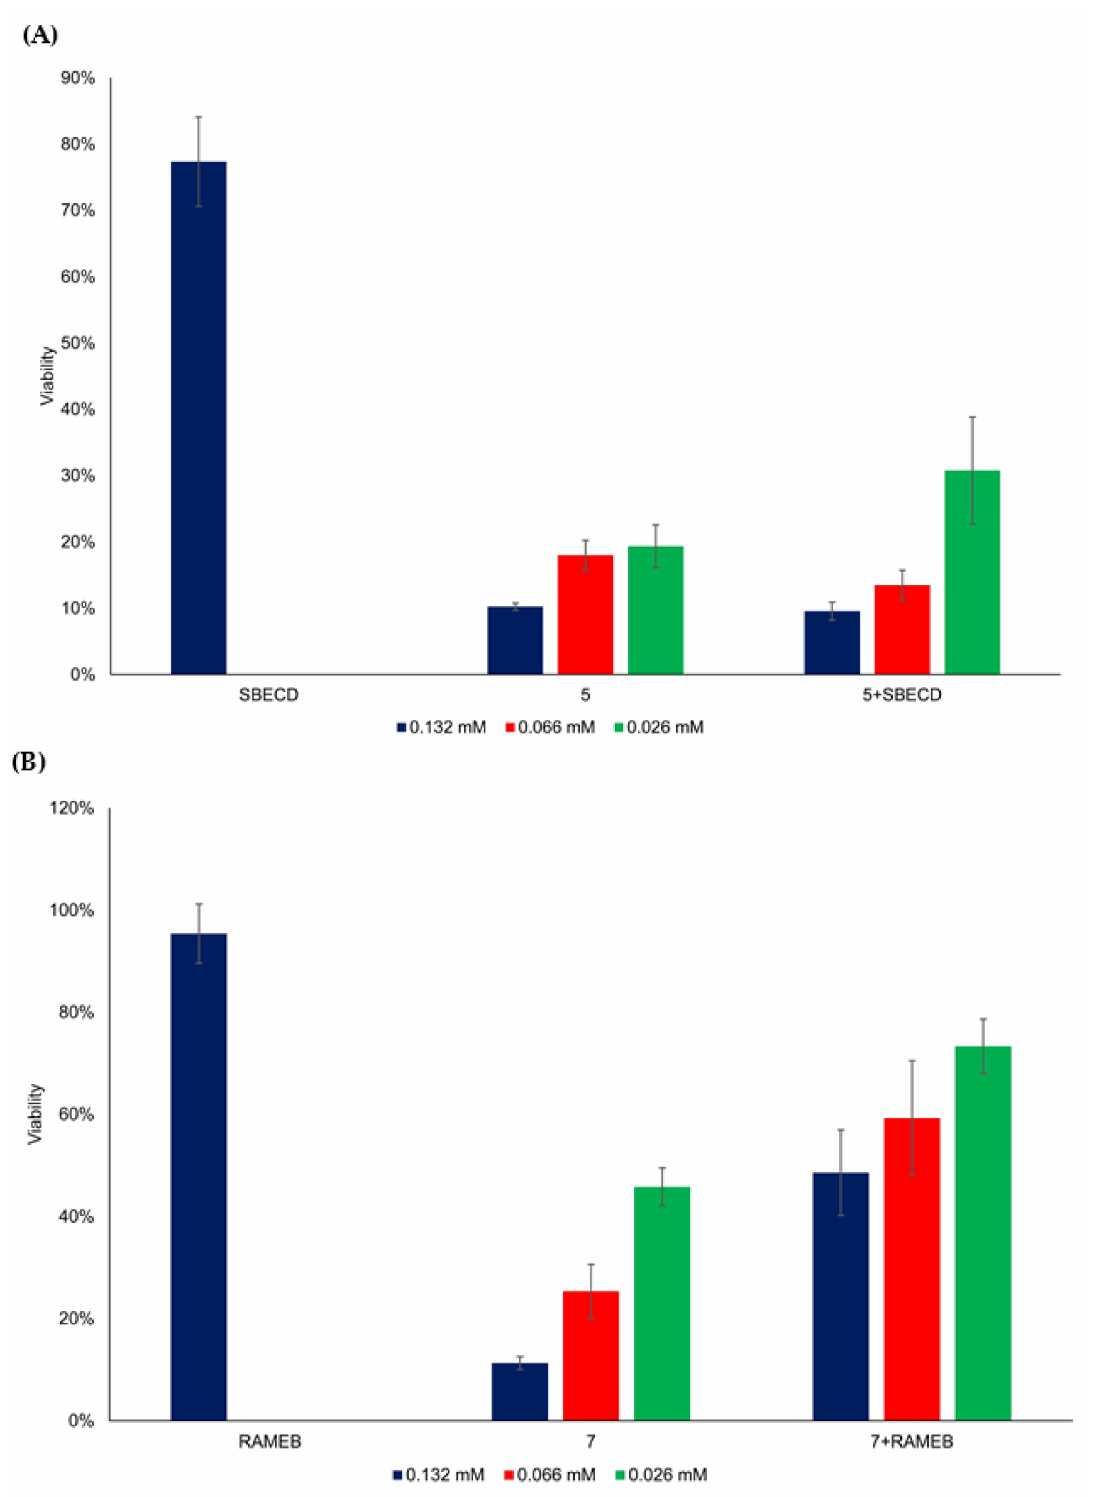
Figure 10. Viability (%) of HepG2 cells as a function of flavylium compounds 5 ( A ) and 7 ( B ), and their cyclodextrin complex concentration with SBECD and RAMEB,